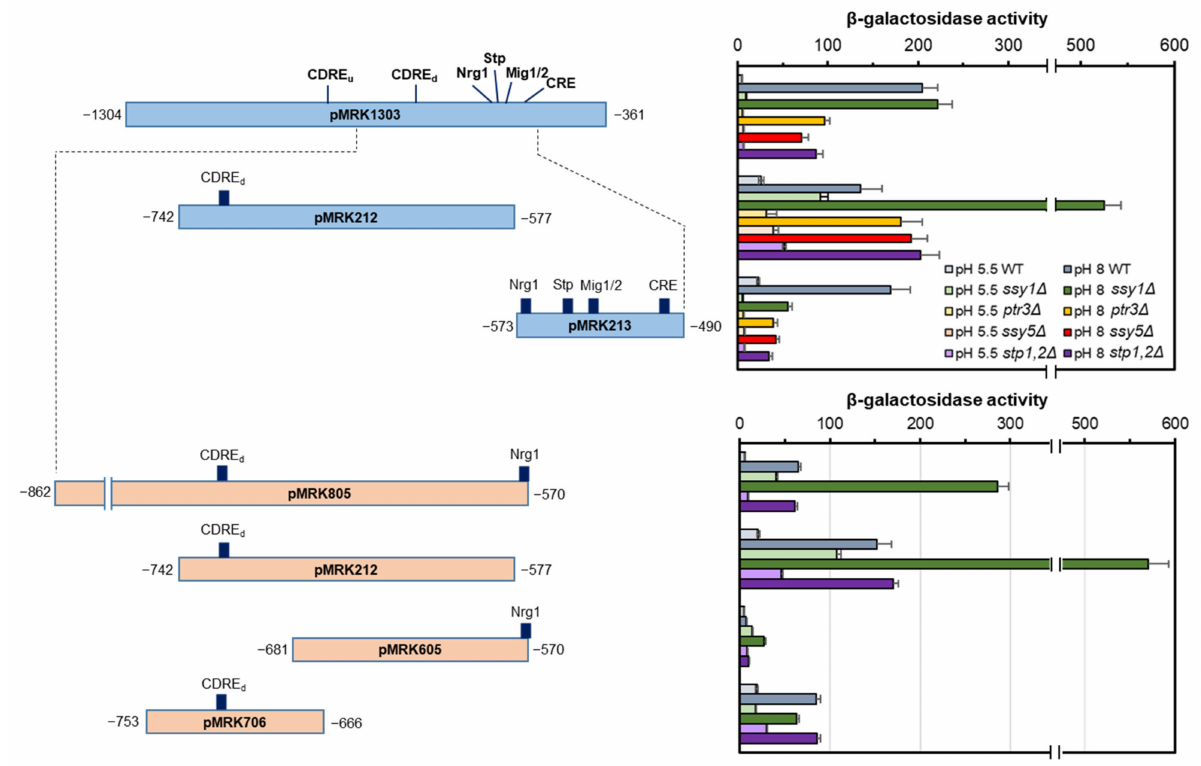
Figure 7. Functional mapping of the alkaline pH response of the ENA1 promoter in mutants in the SPS pathway. The diverse strains (23344c background) were transformed with pSLF ∆ -178K derived reporters containing the indicated fragments, and cells were exposed for 1 h to alkaline pH prior to determination of β -galactosidase activity. The relevant regulatory sites included in each fragment are depicted. Data are mean ± SEM from 6 to 10 independent experiments. A second set of independent determinations for pMRK212 is included in the bottom section for better comparison with the newly constructed